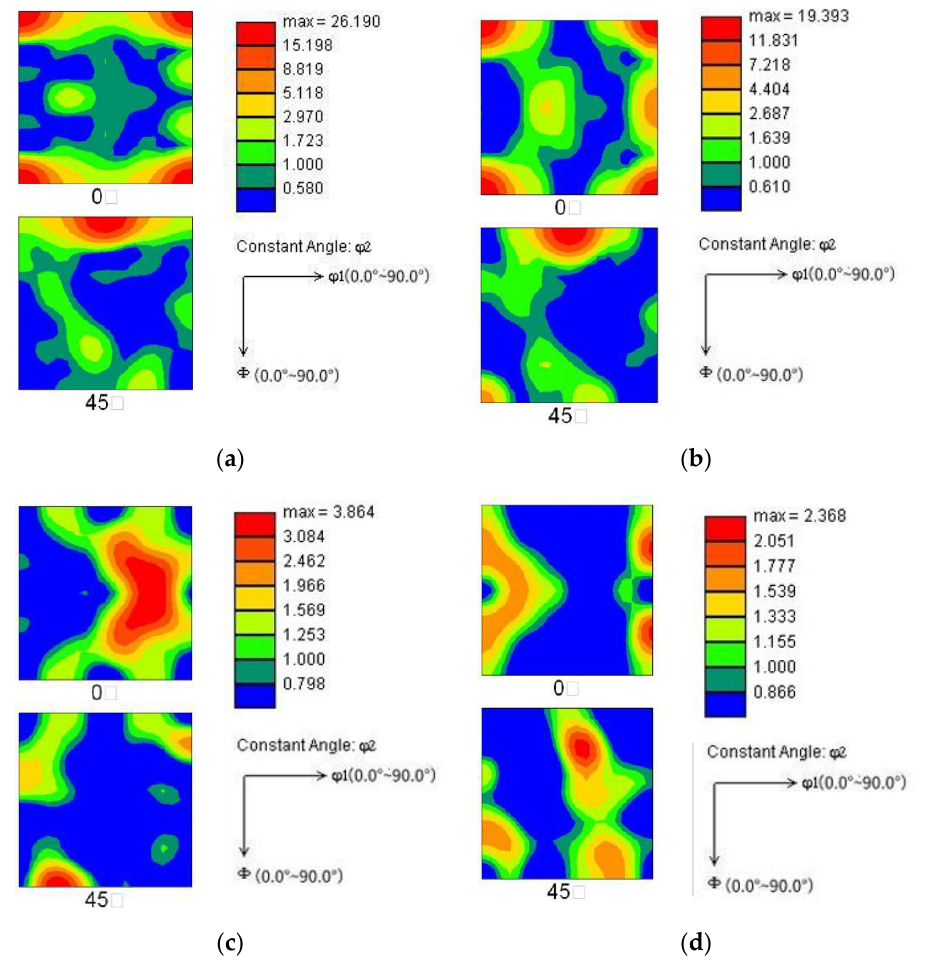
Figure 5. ODFs of ( a ) BM, ( b ) HAZ, ( c ) TMAZ, and ( d ) WNZ in the FSW joint. Table 3. Texture type and proportion of different regions in FSW joint.